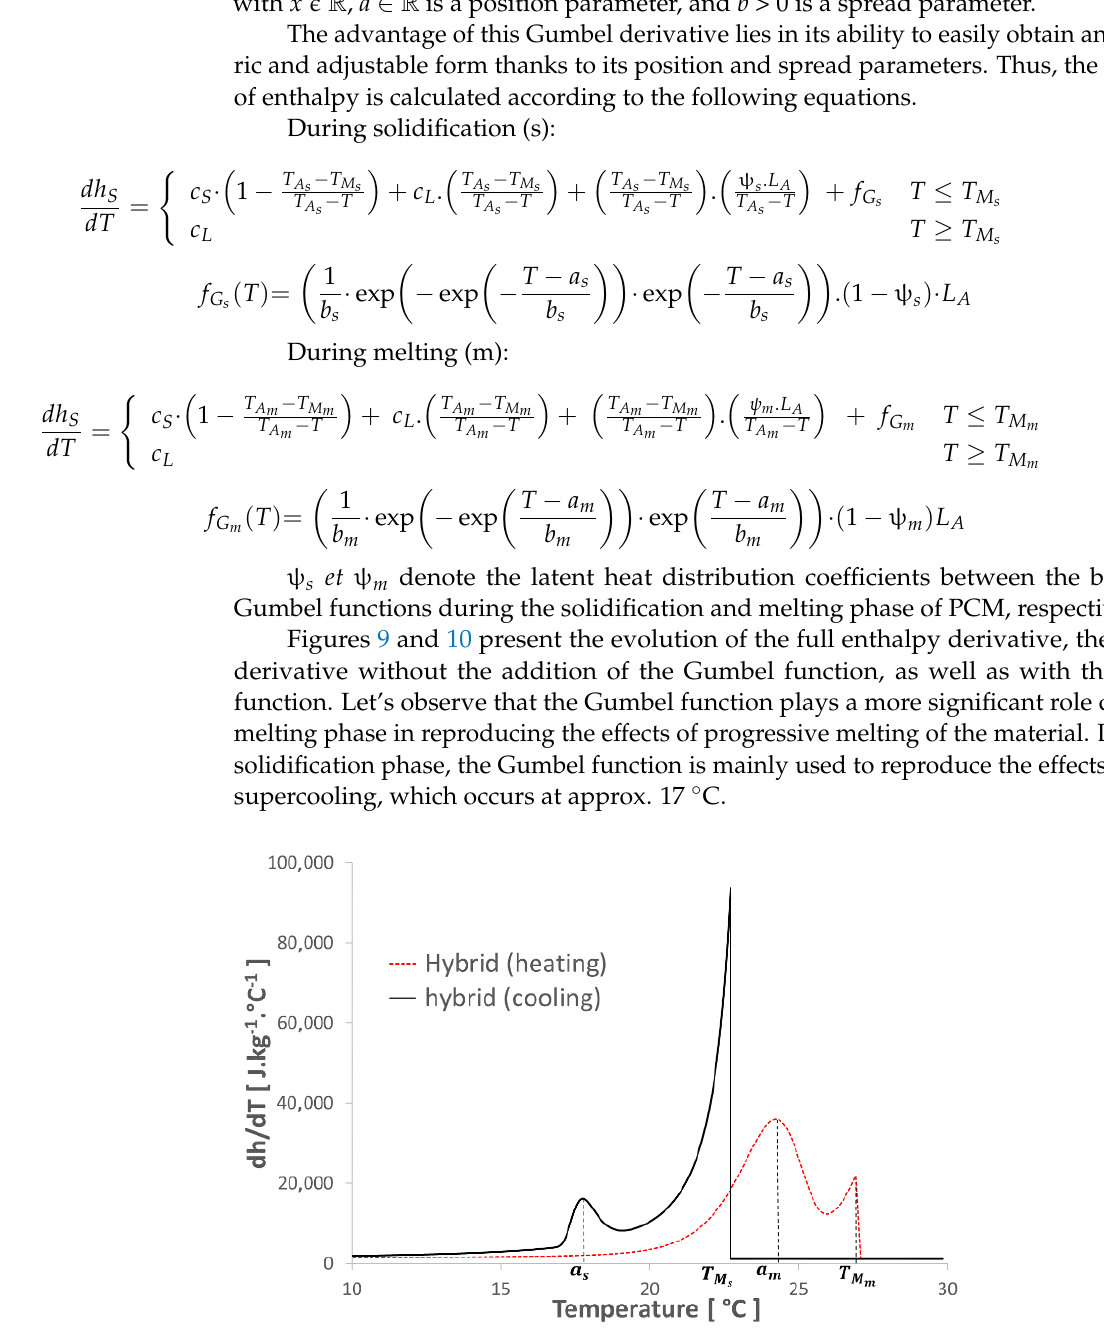
Figure 9. Evolution of the enthalpy derivative vs. temperature (hybrid model).